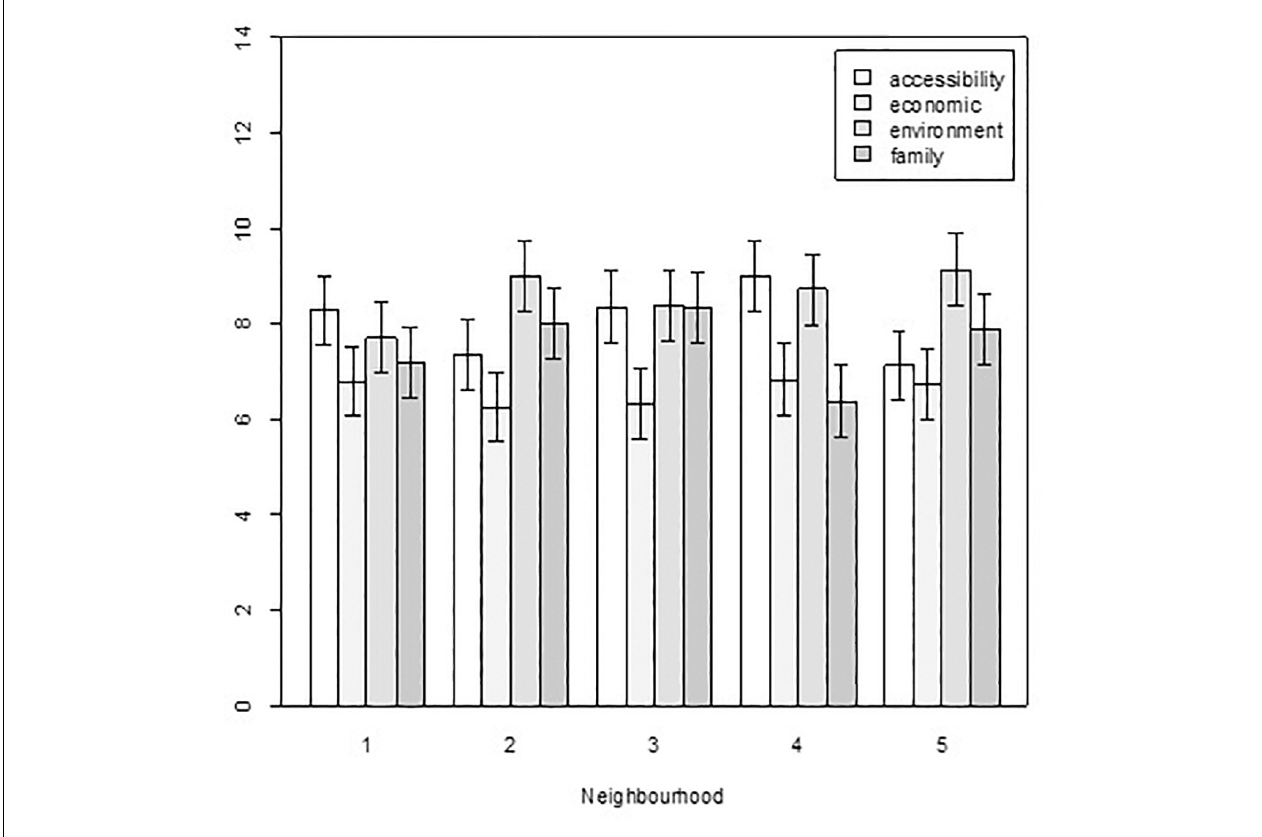
FIGURE 4 | Differences in residential satisfaction by Neighborhood ∗ Reasons